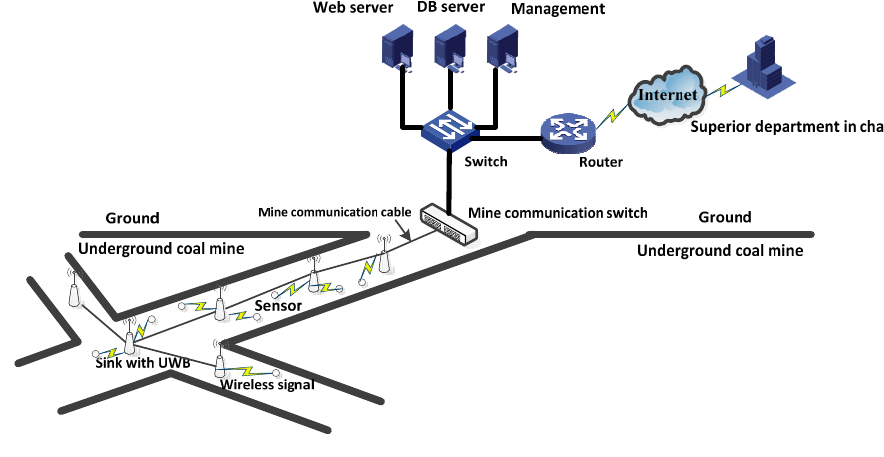
Figure 2. Architecture of multisink WSNs.